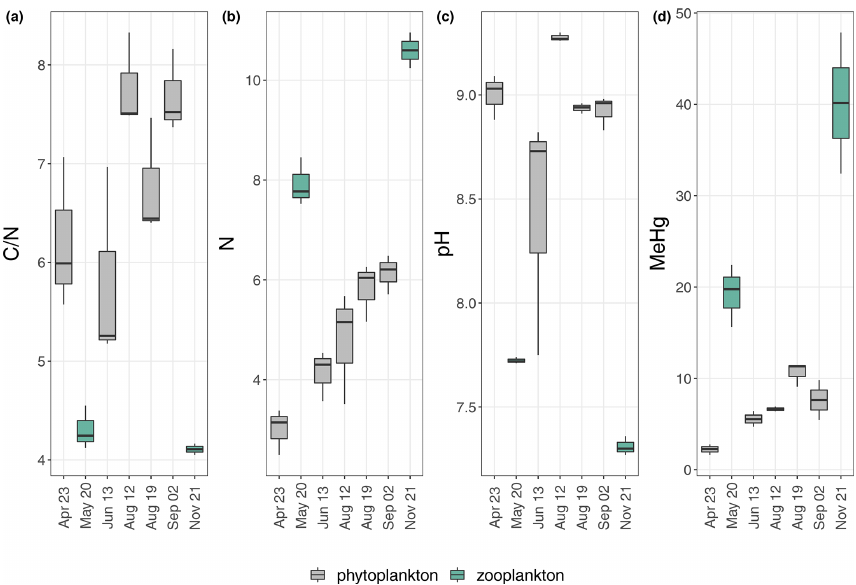
Figure 4. C / N ratio (a) , N concentration (%) (b) , pH (c) and MeHg concentration (ngg − 1 ) (d) of the individual sampling days from the upper 2 oxic meters (0; 1; 2m). Colors indicate differences in plankton dominance; green symbolizes higher amounts of zooplankton; gray symbolizes higher amounts of phytoplankton. The relative dominance of zooplankton was estimated from visible inspection and from pH